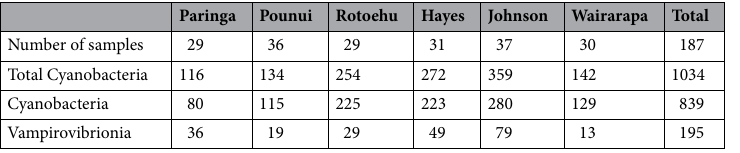
Table 2. Cyanobacterial amplicon sequence variants (ASVs) per lake. Results are given for total cyanobacteria and per Class.